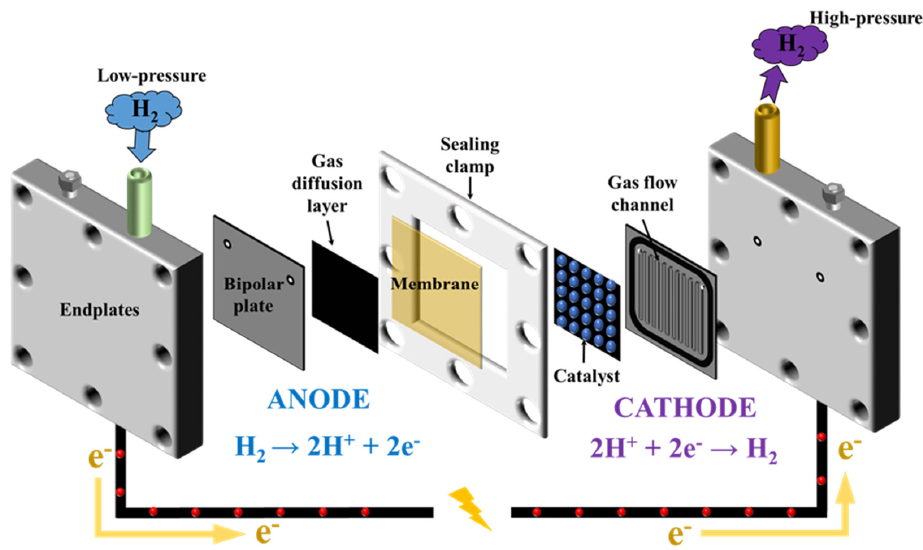
Figure 2. EHC design and principle.